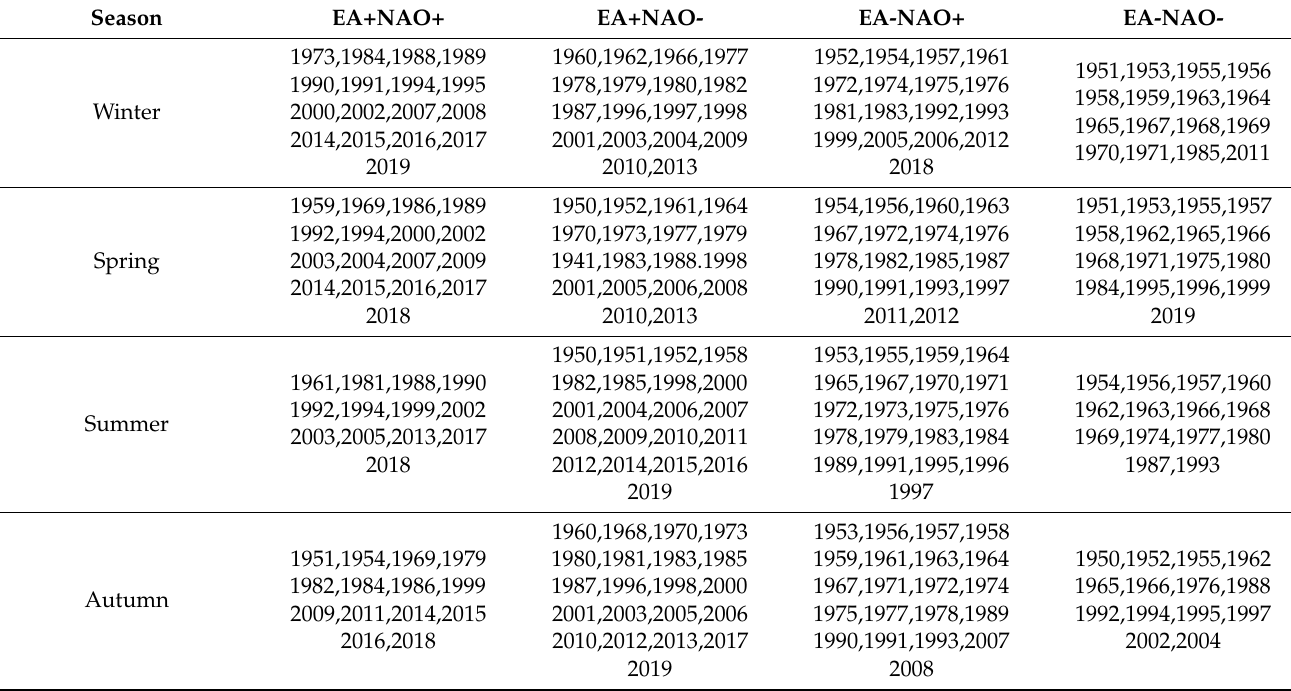
Table 2. Years corresponding to the four EA-NAO